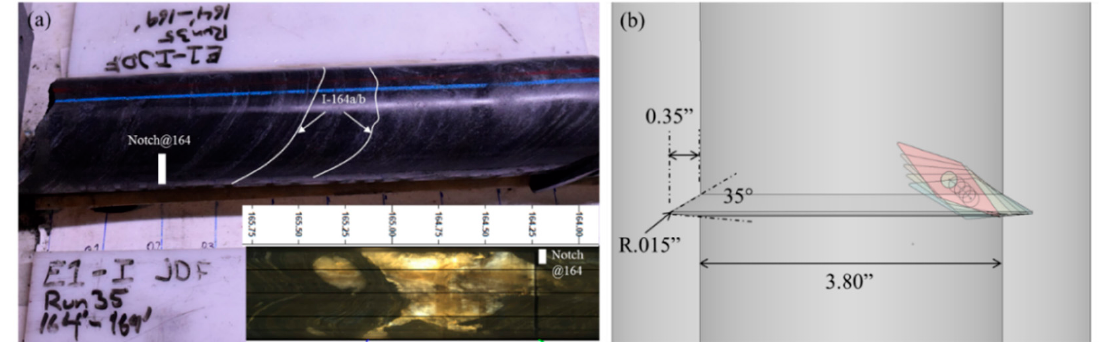
Figure 8. The details of core and notch at 164 ft depth along E1-I [2]. ( a ) Core and acoustic televiewer log showing the fractures in E1-I (at 164 ft to 169 ft depth) [2]. ( b ) sketch of the geometry of Notch ≅ 164 along E1-I [2].